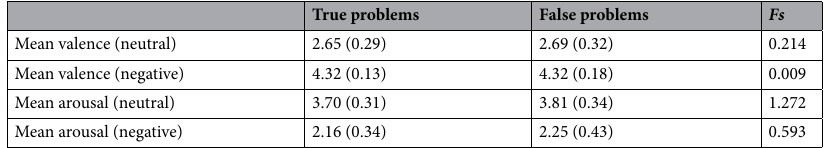
Table 4. Mean valence and arousal in each category of problems ( SDs in parentheses). In DAPS, valence ranges from 1 (very happy) to 5 (very unhappy), and arousal ranges from 1 (very excited) to 5 (very calm).